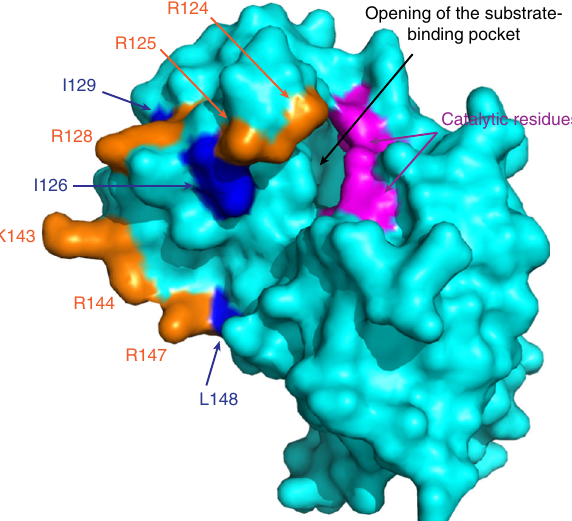
Fig. 5 Surface of the L. plantarum acyl-ACP TE, 2OWN. Positively charged residues in motifs 124 – 129 and 143 – 148 are shown in orange. Residues I126, I129, and L148, which correspond to L257, I260, and L289 of CvFatB2, respectively, are shown in blue, and these are adjacent to positively charged motifs. Catalytic residues are shown in